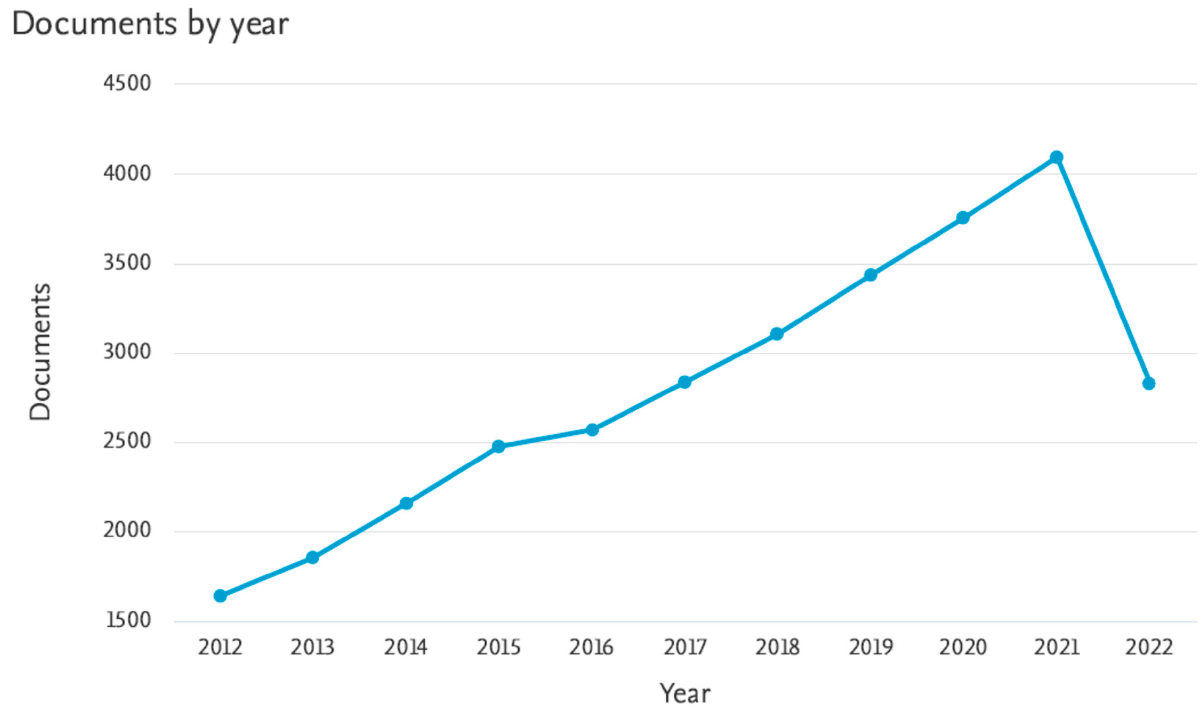
Figure 3. Articles published on coumarin–metal complexes from 2012–2022.